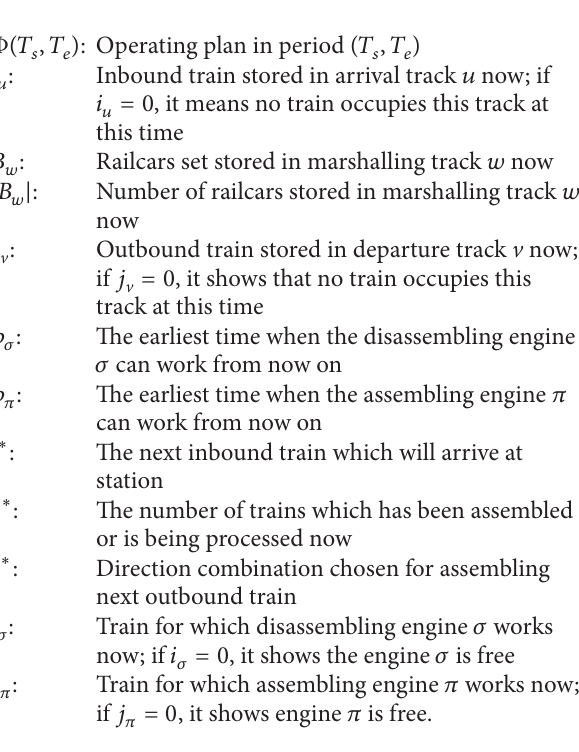
disassembling railcars per minute